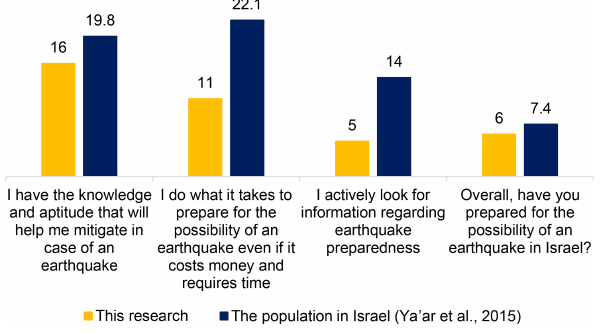
Figure 5. Level of knowledge and readiness to prepare for an earth- quake in Israel. The percentage of people who greatly agree with these